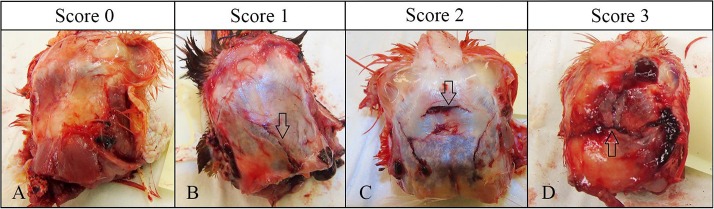
Gross pathology scoring criteria for skull fractures. Arrows indicate the fracture type [modified from Erasmus et al. (12) and Casey-Trott et al. (15)]. (A) No fracture, intact skull (score 0). (B) Depression fracture (score 1). (C) Penetrating fracture-no imbedded fragments (score 2). (D) Penetrating fracture- with imbedded fragments (score 3).